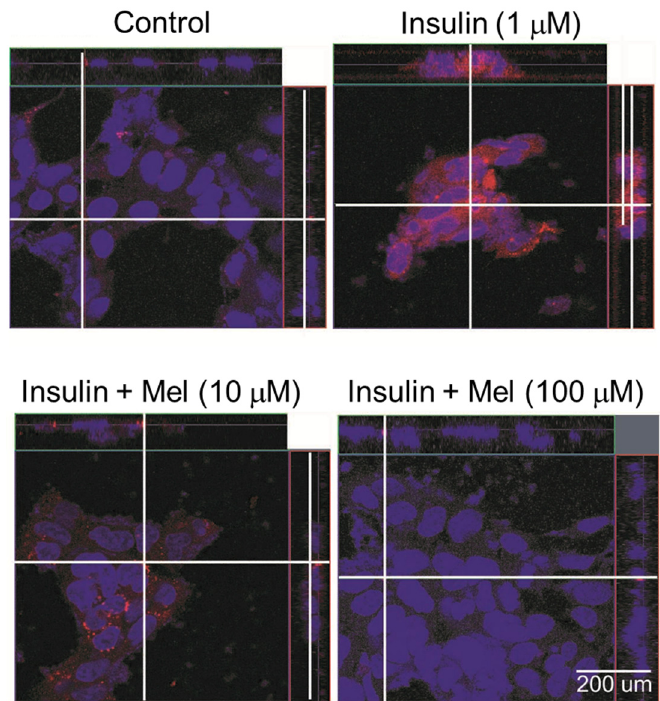
Figure 5. Melatonin attenuates the activation of ASK1 in insulin stimulated SH-SY5Y cells. Immunofluorescence staining was performed to check the activation of ASK1 ( p-ASK1 ). Confocal microscopy analysis was performed to visualize p-ASK1 . SH-SY5Y cells were pretreated with melatonin for 24 h before insulin stimulation. p-ASK1 is represented by red staining, nuclear DNA is indicated by DAPI staining (blue color), and the combined images are presented; Control: non-treated cells, Mel: melatonin.